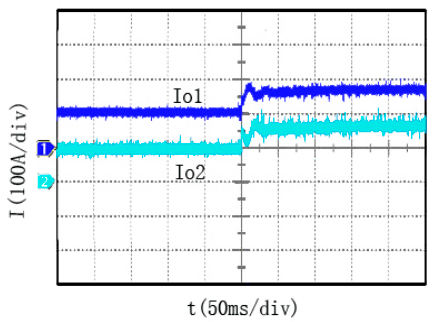
Figure 18. Switching the light load to the heavy load.